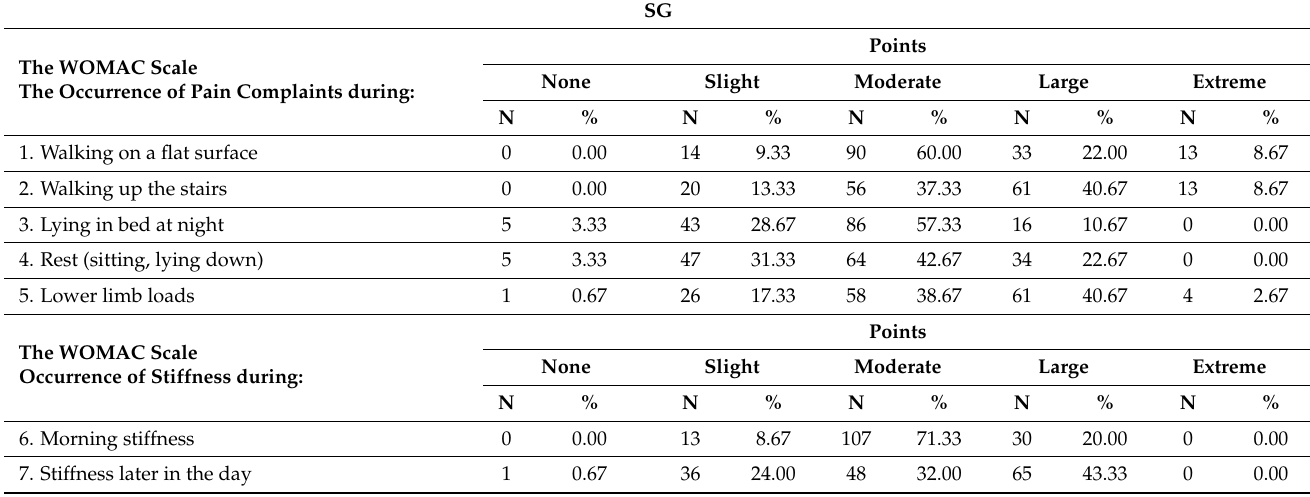
Table 4. Distribution of respondents’ responses in terms of pain, stiffness and limitations in daily